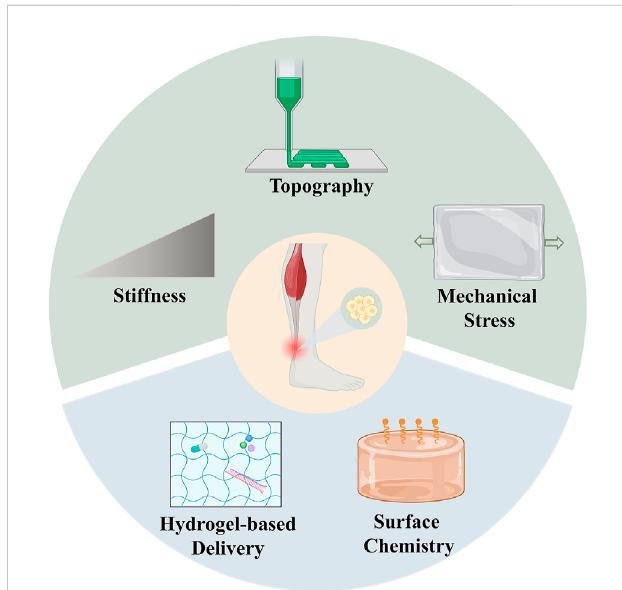
FIGURE 4 Strategies of hydrogels with tunable biophysical and biochemical factors for stem cell therapies in tendon repair. The upper part represents the biophysical factors of hydrogels, which include stiffness, topography and mechanical stress. The lower part represents the biochemical factors of hydrogels, which include hydrogel-based delivery and surface